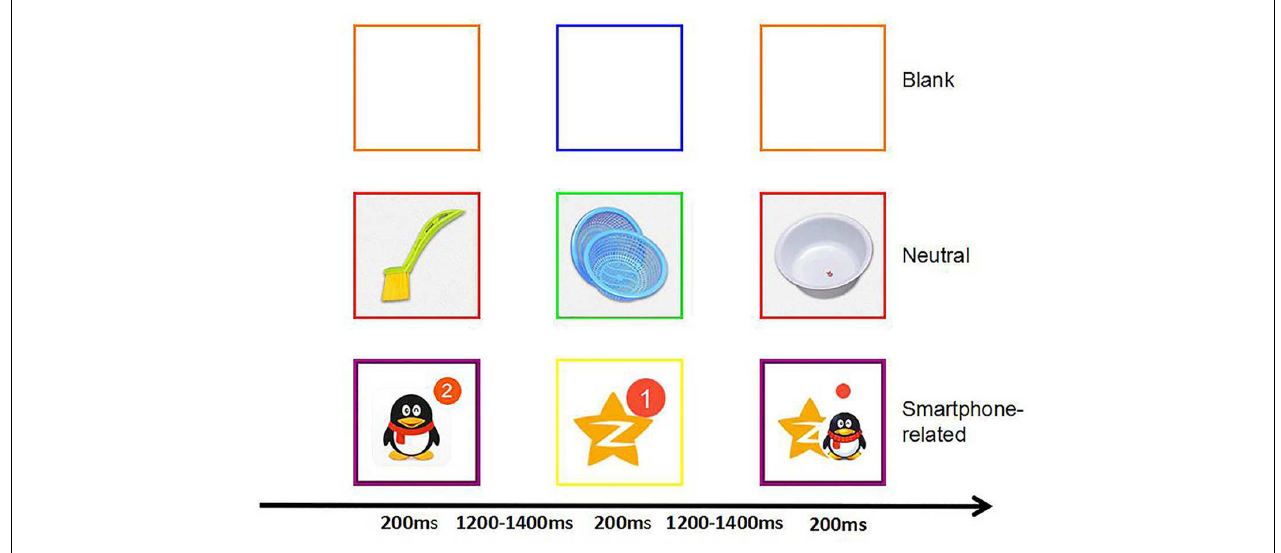
FIGURE 3 | Trial design for a modified Go/NoGo task. In this task, participants were presented with six blocks of 250 trials, divided in 200 Go trials and 50 NoGo